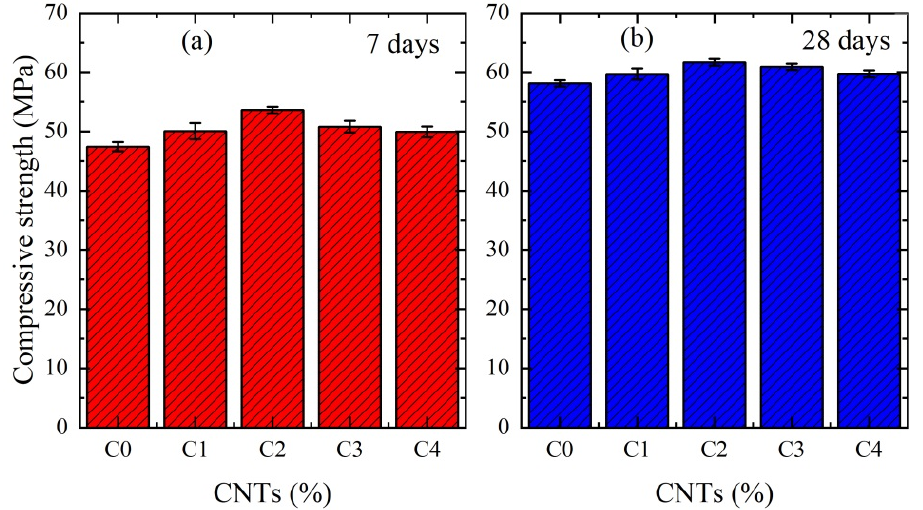
Figure 4. Compressive strength of cement mortars with different wt.% of MWCNTs. The results are for 40 min of ultrasonication time without surfactant. ( a ) for 7 days ( b ) for 28 days. Figure 5a,b show the compressive strength of the mortar with different wt.% of MWCNTs for 7 and 28 days, respectively, when the surfactant in the MWCNT/water was added. For both cases of curing days, the optimal values of the MWCNT concentration have been obtained at 0.01 wt.%. The improvement in the efficiency of the dispersion process of MWCNTs in the water brought an increase in the maximum value of the compressive strength. In particular, the strength of a sample with 7 curing days increased by 19.5%, and by 13.8% in the case of 28 curing